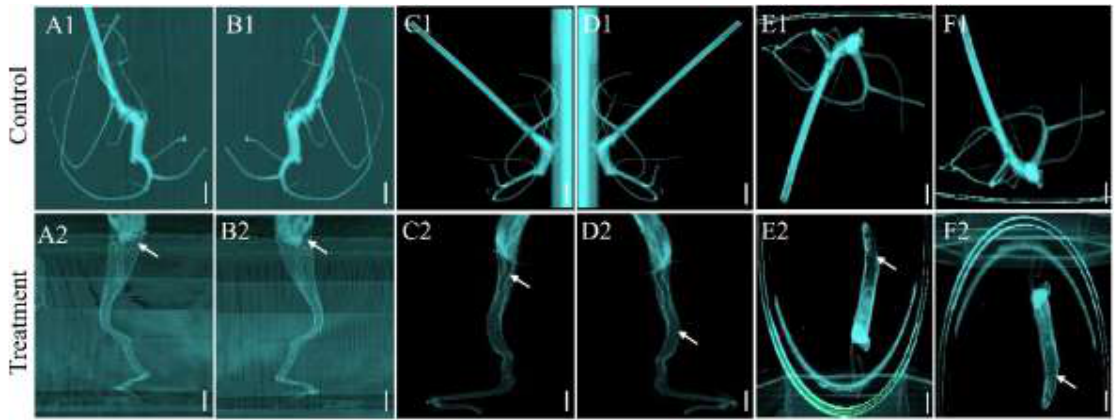
Figure 5. A 3D reconstruction of poplar roots from different perspectives. ( A1 , A2 ) anterior; ( B1 , B2 ) posterior; ( C1 , C2 ) left; ( D1 , D2 ) right; ( E1 , E2 ) superior; ( F1 , F2 ) inferior. The scale is 1 cm. The white arrow represents the locations of the density changes.